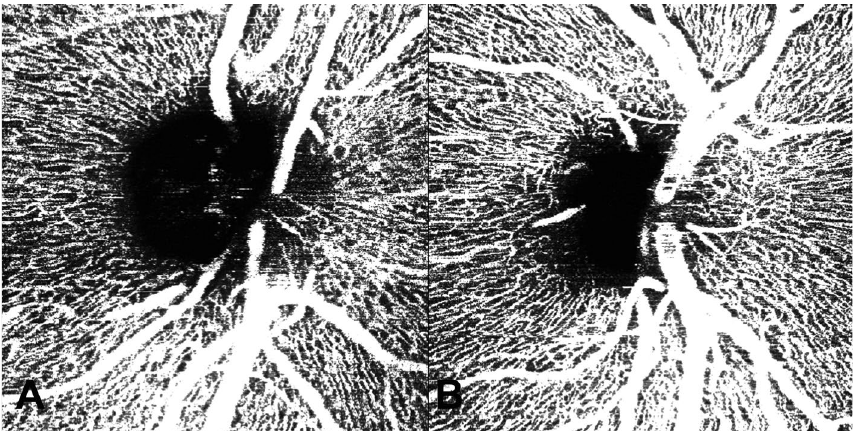
Figure 1. Peripapillary OCT-Angiography capillary plexus in VHL eye ( A ) and Healthy control ( B ). En face OCT-Angiography of the Radial Peripapillary Capillary Plexus showed reduced vascular perfusion in a VHL eye ( A ) compared to a healthy control ( B ). Quantification of plexus perfusion, expressed through evaluation of Vessel Area Density (VAD), Vessel Length Fraction (VLF), Vessel Diameter Index (VDI), Fractal Dimension on binary image (FDbin) and Fractal Dimension on skeletonized image (FDsk) indexes, detected a significant reduction in VHL eyes of VDI parameter.